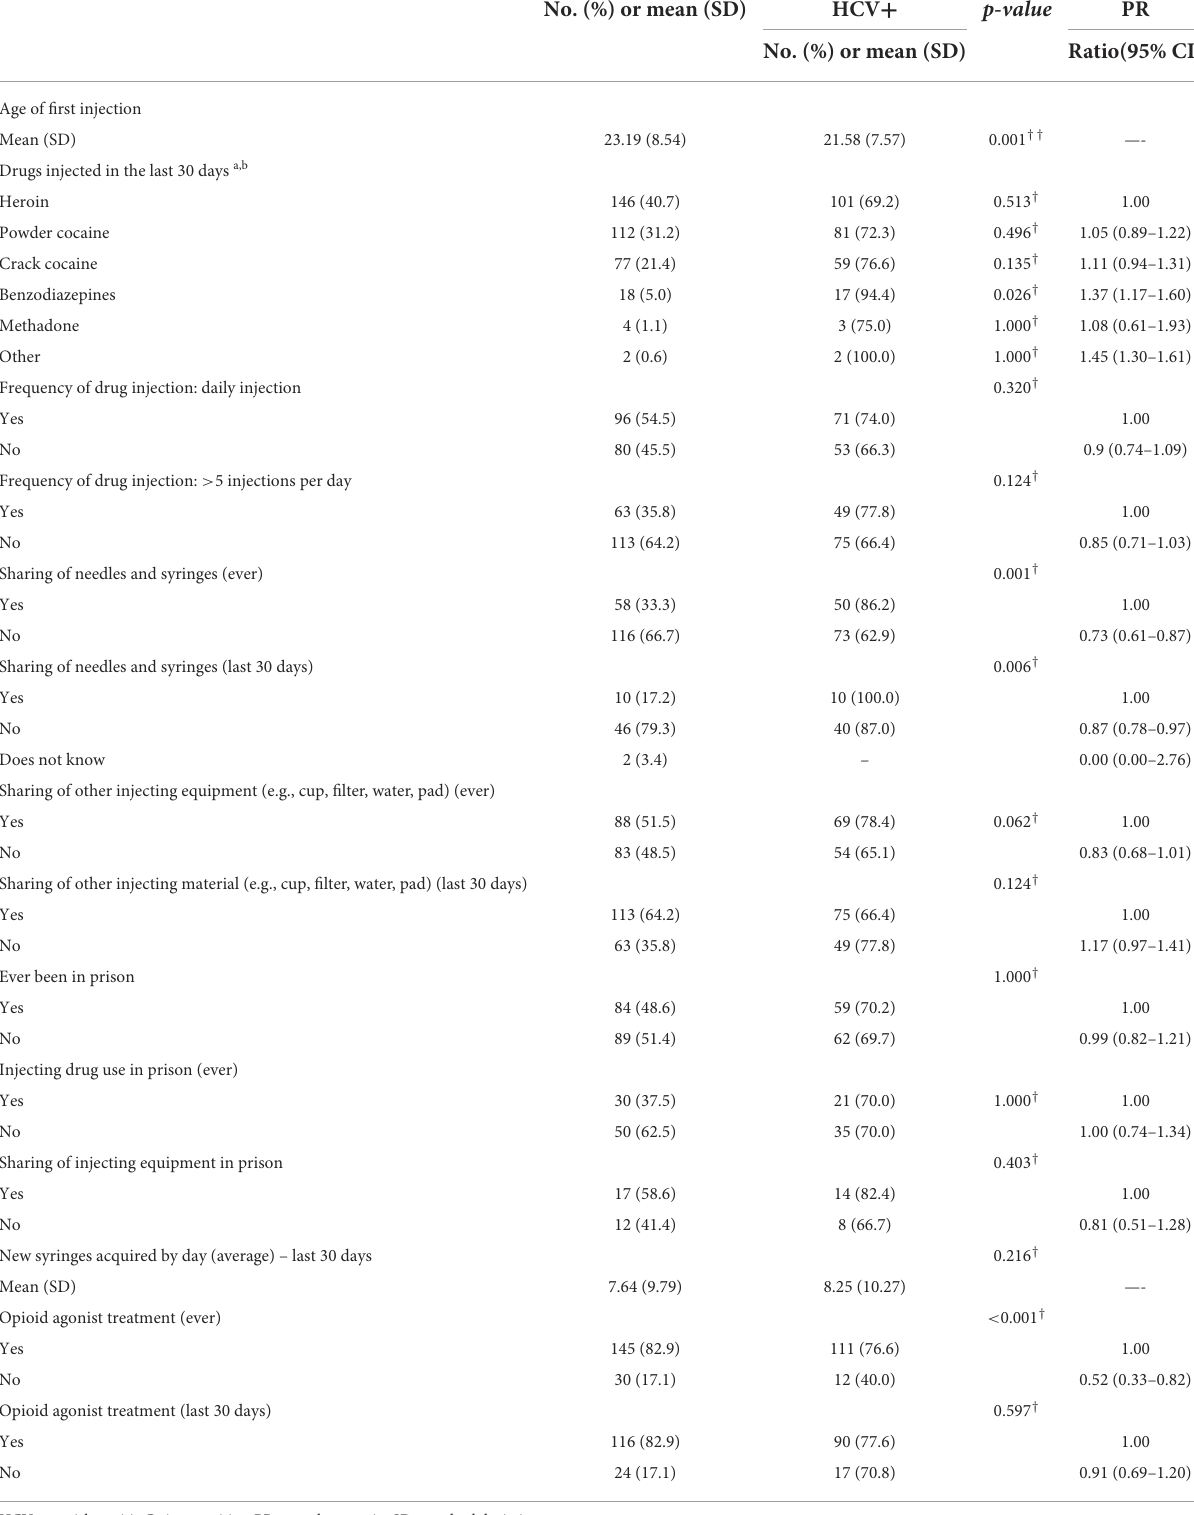
TABLE 2 Drug consumption, and needle and syringe